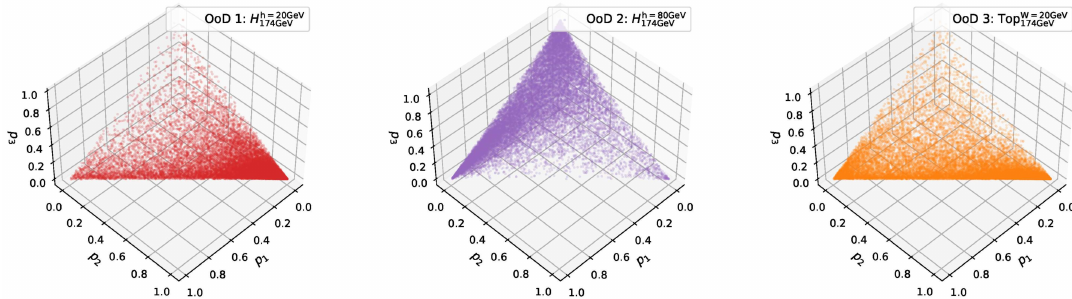
Figure 3 . Softmax simplices of out-of-distribution classes within a mass-decorrelated QCD/W/Top classifier. ( { p k } 3 denotes the corresponding softmax probabilities in classes of QCD, W, and k =1